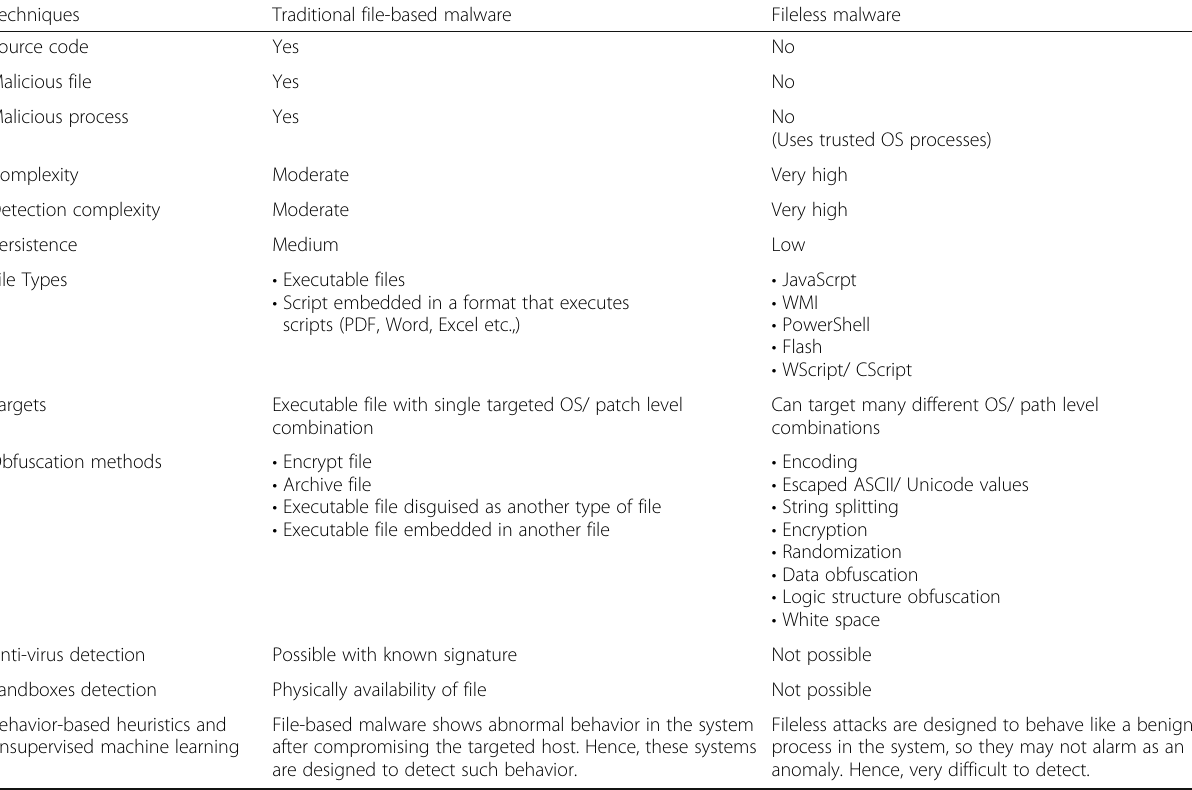
Table 2 Comparison between file-based malware and fileless